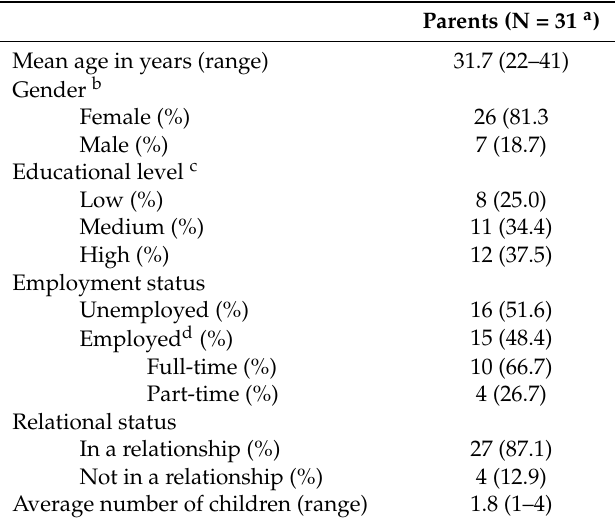
Table 2. Demographics of